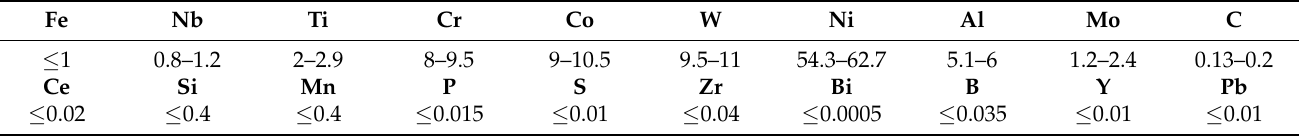
Table 1. Element composition of ZhS6U alloy (wt%).